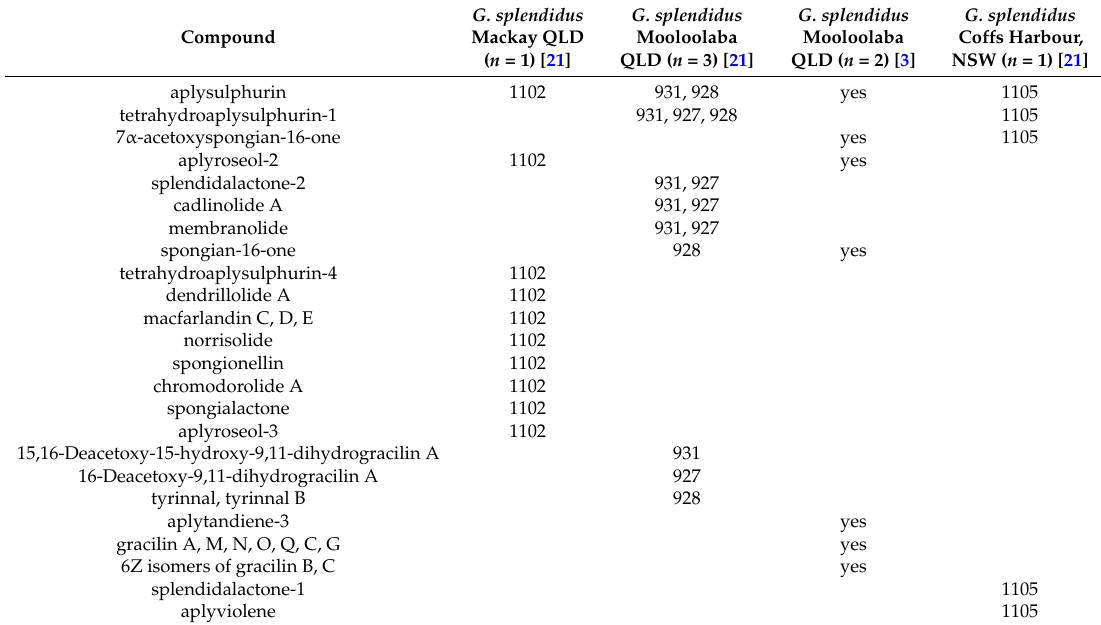
Table 2. Comparison of G. splendidus oxygenated terpenes from a range of geographic localities [3,19]. Specimens are referred to by voucher number if separation of individuals was possible. Compounds in upper section of table are recovered from multiple localities, compounds in middle section are found in multiple individuals. Compounds in the lower section are unique to one